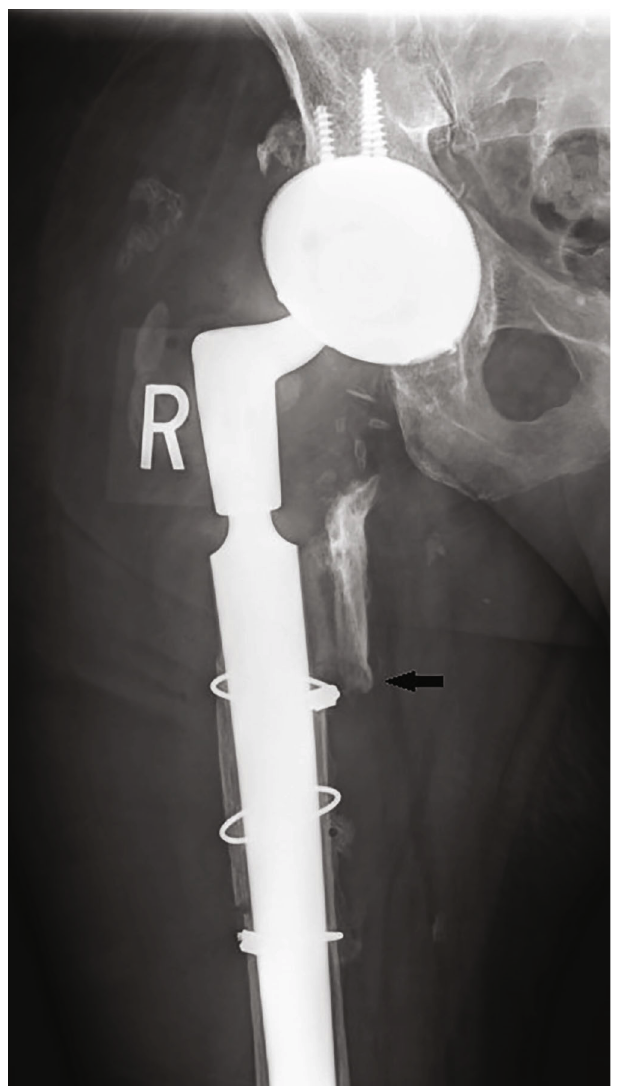
Figure 4: Anteroposterior X-ray of the right hip after reimplantation with fi xation.